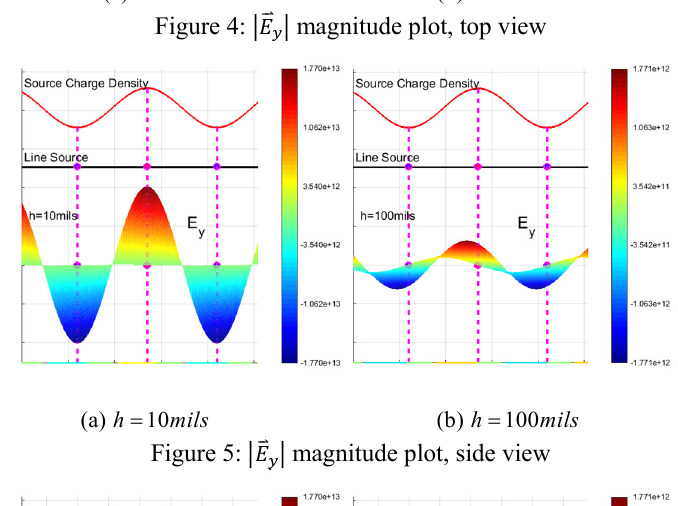
Figure 5: ⃑ magnitude plot, side view